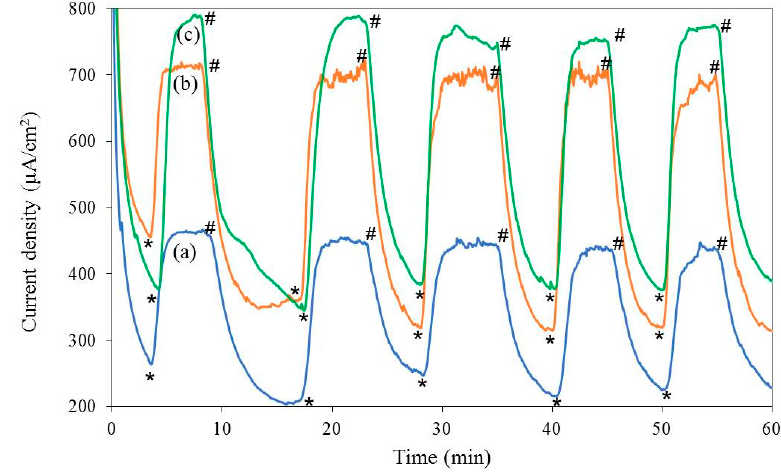
Figure 5. Chrono-amperograms at 1.00 V (vs Ag / AgCl) in 0.2 M Na 2 SO 4 (pH 12) over 1 h of operation, with and without light illumination (0.25 sun), of Fluorine doped tin oxide (FTO) glass slides coated with thin films of: ( a ) polypyrrole only (control), ( b ) polypyrrole containing irregular-shaped CaMn 2 O 4 particles, and ( c ) polypyrrole containing CaMn 2 O 4 nanowires. (* = ‘light on’, # = ‘light off’).